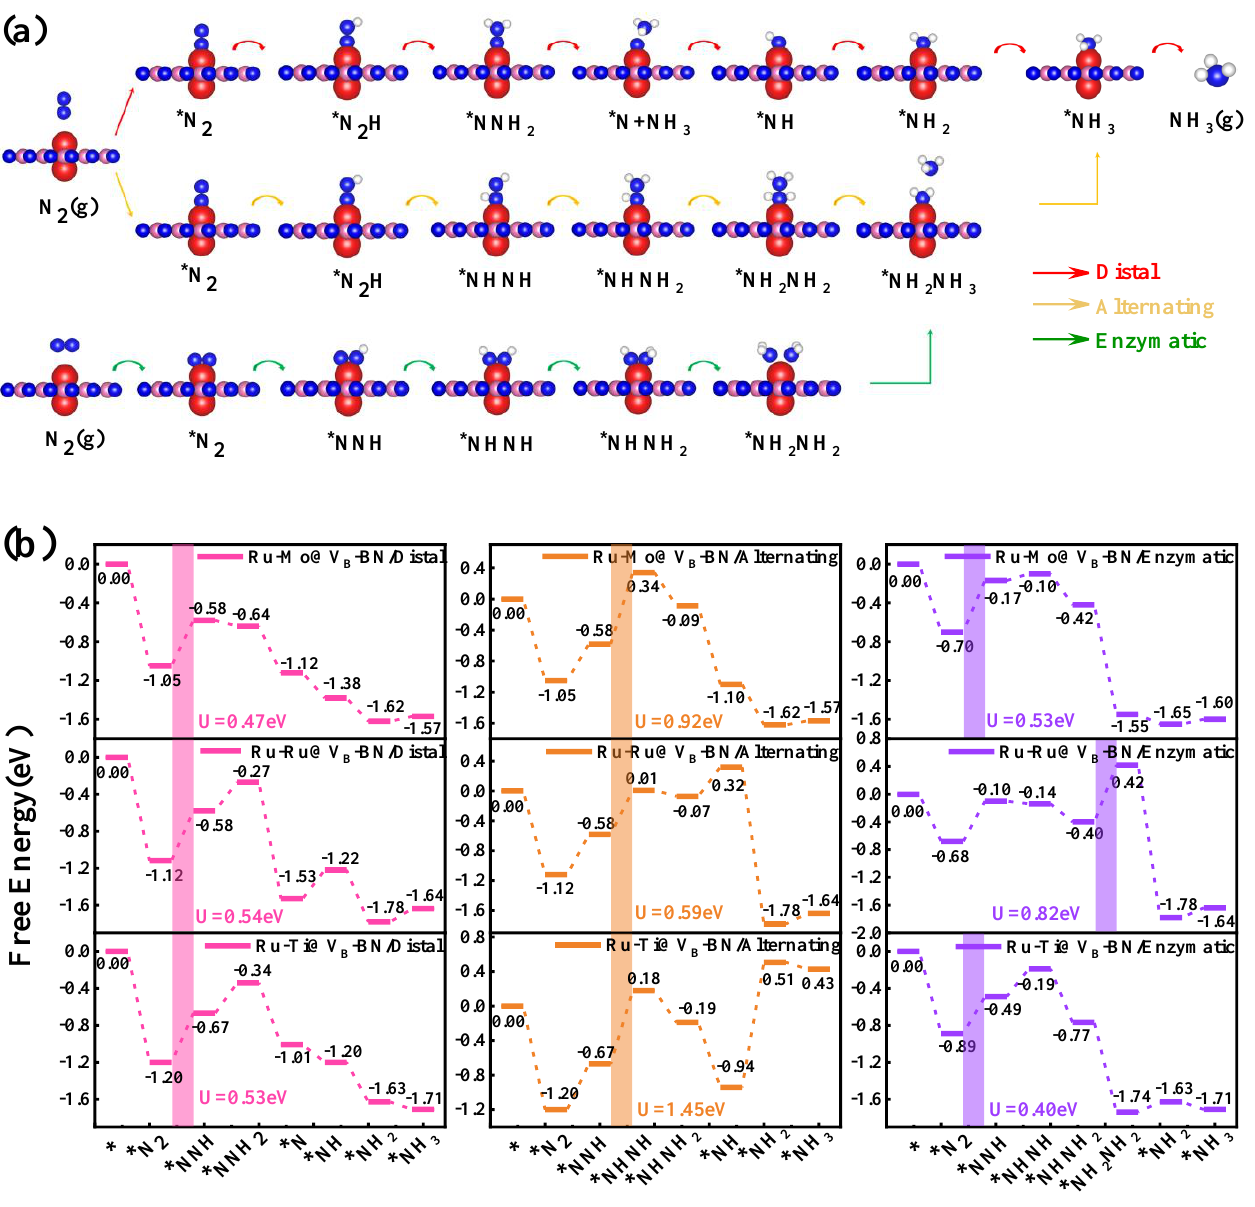
Figure 5. ( a ) Schematic diagram of the possible reaction mechanisms and geometry structures of the corresponding intermediate products during the NRR process. ( b ) Gibbs free energy diagram for NRR on Ru-Mo@V B -BN, Ru-Ru@V B -BN and Ru-Ti@V B -BN catalysts. Taking the optimal Ru-Ti@V B -BN as an example, we further examined the evolution behaviors of the Bader charge of each intermediate along the favorable enzymatic mechanism. During the whole NRR process, each intermediate was divided into three parts, namely the defective BN monolayer, the TM dimer and the adsorbed N x H y species. Figure 6a shows the variations of the Bader charge of three parts, and all the data are summarized in Supplementary Table S12. The adsorbed N x H y and V B -BN can gain electrons from the Ru-Ti pairs for the N 2 adsorption and the former two hydrogenation steps. Then the electrons of the adsorbed N x H y backflow to the Ru-Ti dimer for the *NNH 2 formation. In the following hydrogenation processes, N x H y species continue to acquire electrons from Ru-Ti, and the backflow of electrons occur until the subsequent desorption of NH 3 . Thus, the defective BN monolayer acts as an electron acceptor during NRR, while Ru-Ti pairs always reserve as the electron donors in the process of trapping the